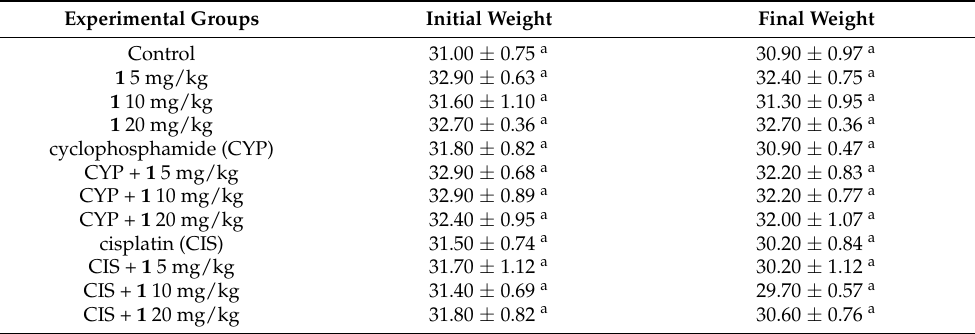
Table 1. Mean ± Standard error of initial and final weight of Swiss mice treated with different doses of 1